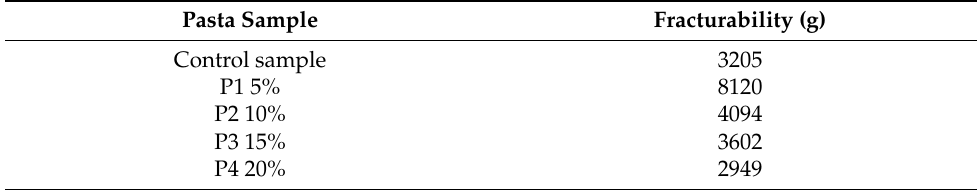
Table 4. Dry pasta